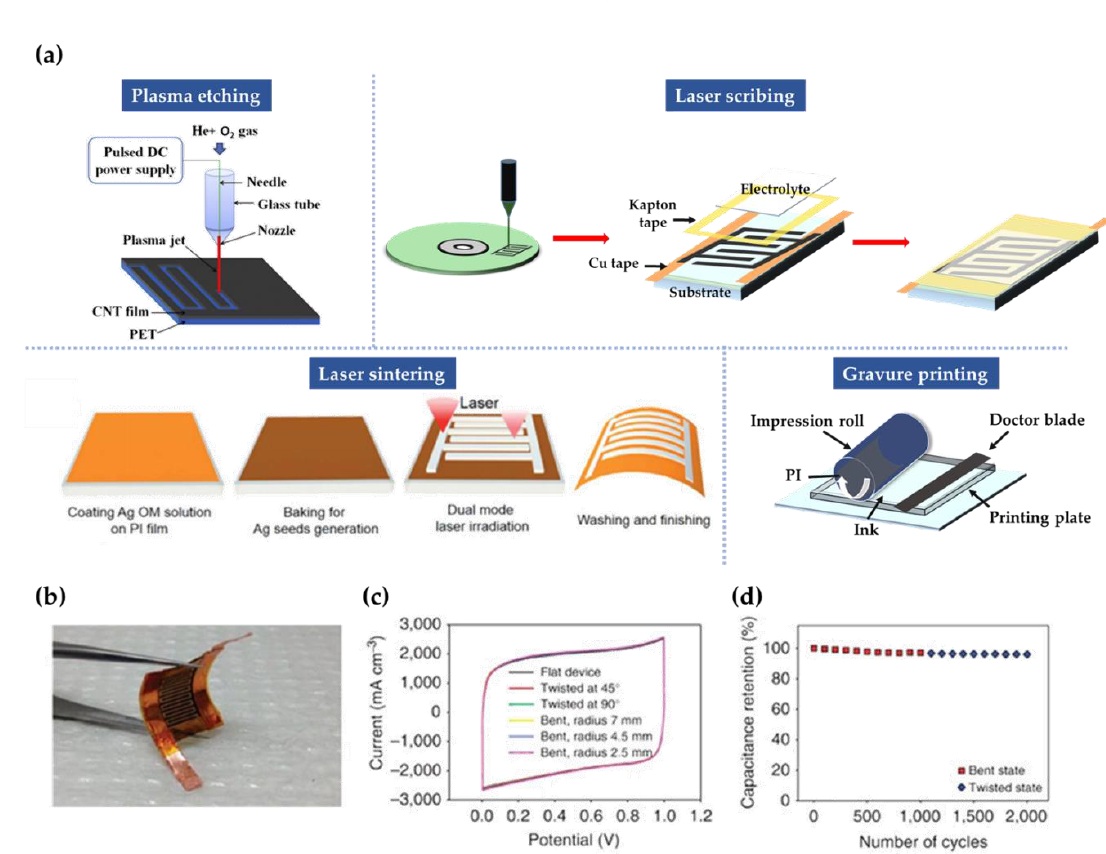
Figure 6. ( a ) Schematic illustration of every methodology fabricating flexible MSCs [61,68,73,76]. Copyright (2017), Science direct. Copyright (2013), Nature Communications. Copyright (2017), Journal of Materials Chemistry. ( b – d ) Mechanical and electrochemical performance of MSCs fabricated by the laser-scribing method [68]. Copyright (2013), Nature Com- munications.